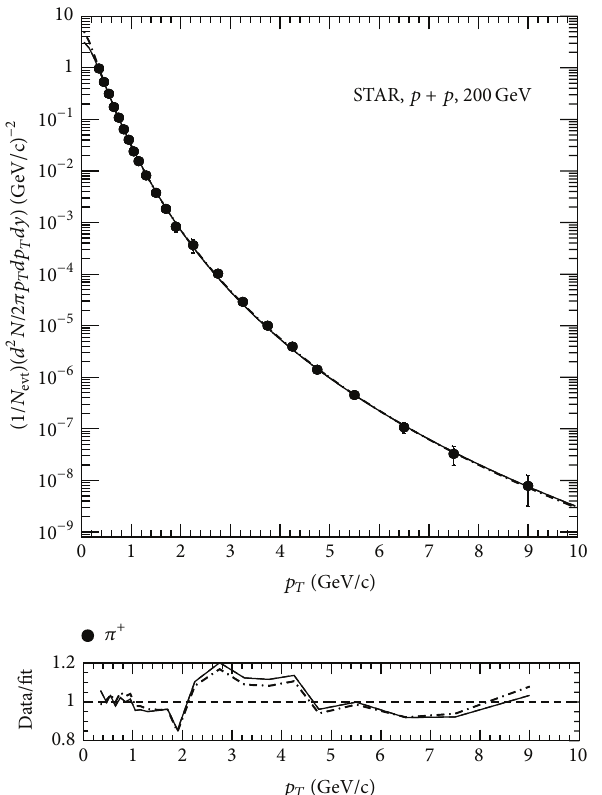
Figure 1: Fitting results using the distributions equations (5), (8), (9), (10), and (2) for 𝜋 + in 𝑝 + 𝑝 collisions at √𝑠 = 200 GeV. The solid line, dashed line, dotted line, dash-dotted line, and bold dash-dotted line refer to (5), (8), (9), (10), and (2), respectively, but they are hardly to distinguish. The ratios of data/fit are shown at the bottom. Data are taken from STAR